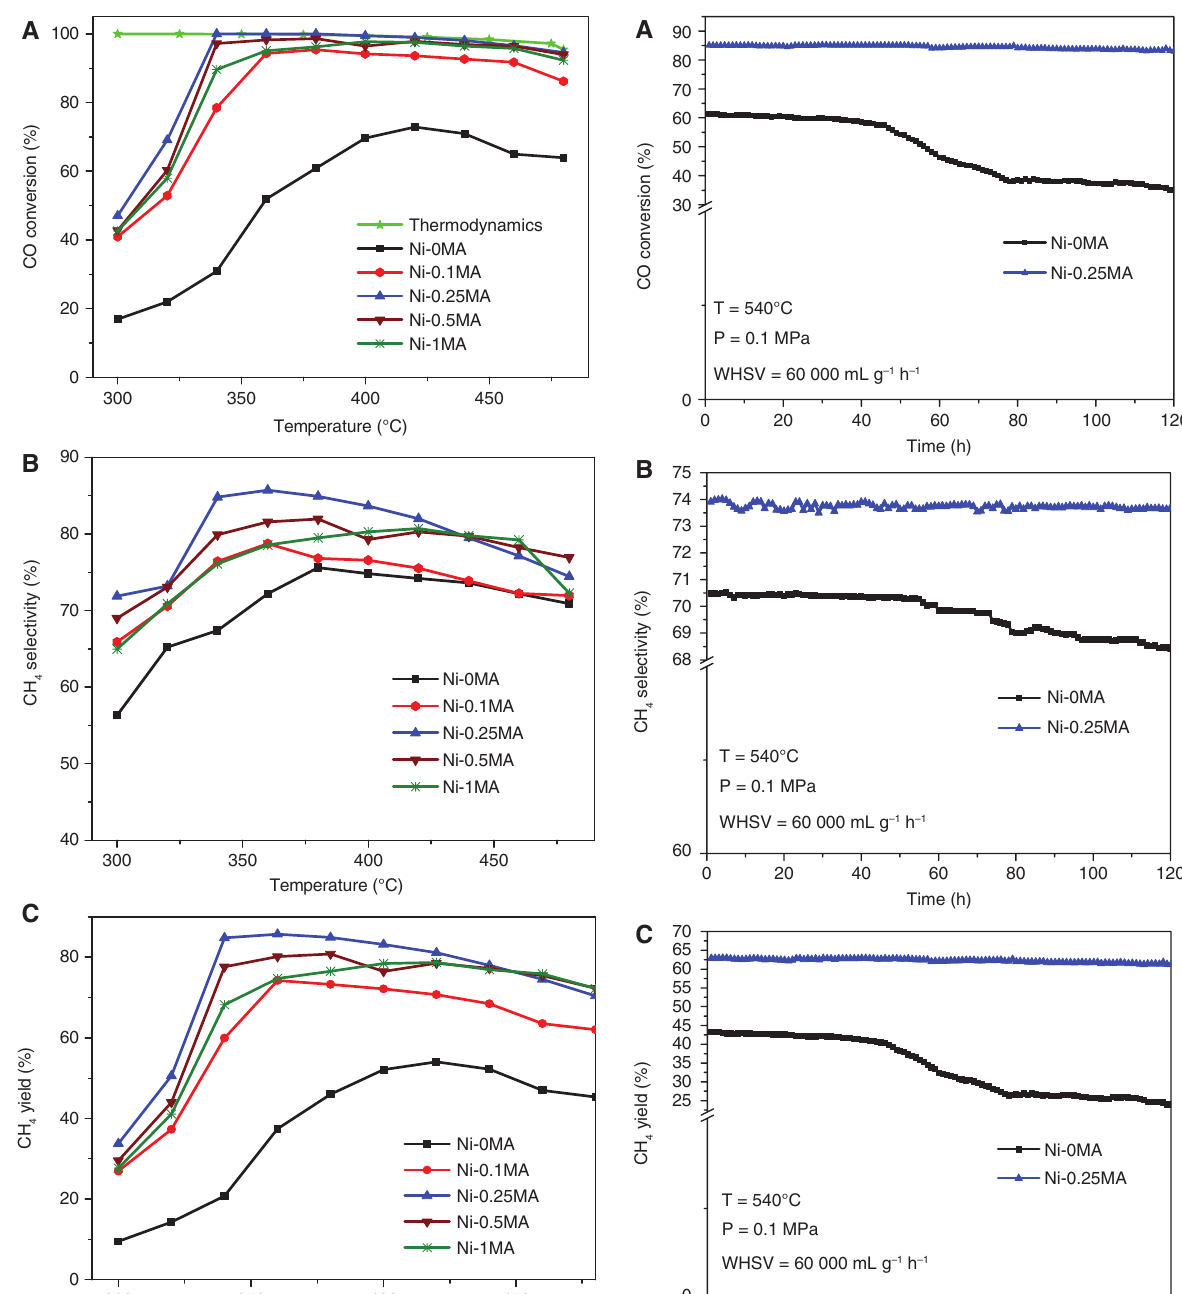
Figure 9: Catalytic properties of the catalysts at 60 000 mL g −1 h −1 , 0.1 MPa: (A) CO conversion, (B) CH